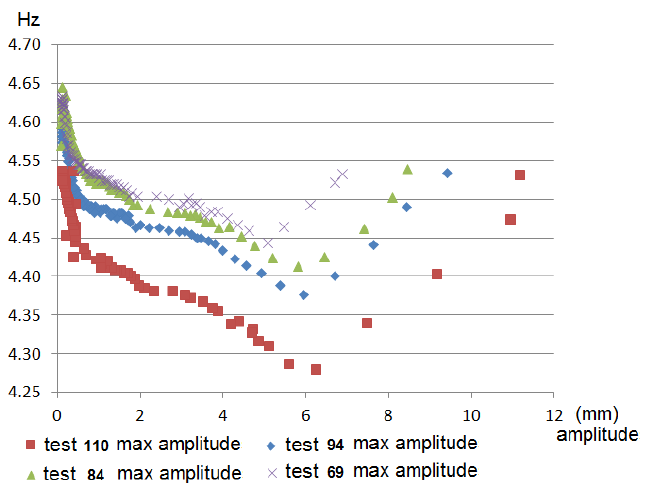
Figure 16. Graphs of the variation of the frame frequency – amplitude in free decay period with clamped joints for each of the tests according to the maximum amplitude at which the table was oscillated.